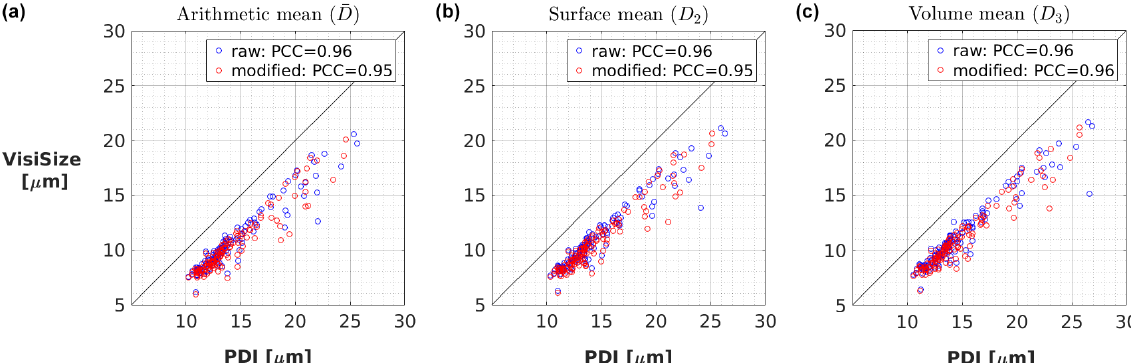
Figure 6. Comparison of cloud mean droplet diameter between the VisiSize and the PDI probe. Scatter plots of the arithmetic mean ( D , a ), surface mean ( D 2 , b ), and volume mean ( D 3 , c ) are shown from left to right. Each pair of blue and red circles indicates the raw/modified data for a selected measurement of ∼ 15min. Pearson correlation coefficients (PCCs) are also shown in the legend as an index of the linear correlation.